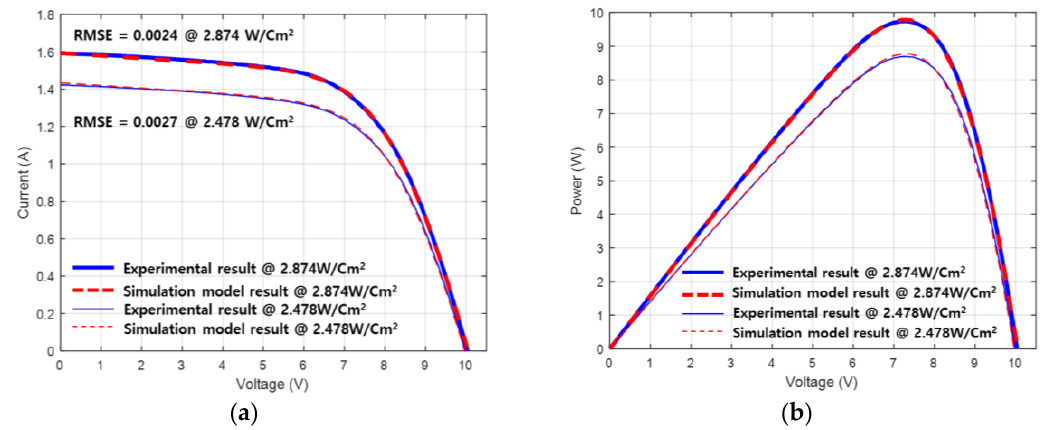
Figure 16. Characteristics of laser PV module using simulation model: ( a ) V–I characteristics comparison between the simulation model and experimental results; ( b ) V–P characteristics of the simulation model.